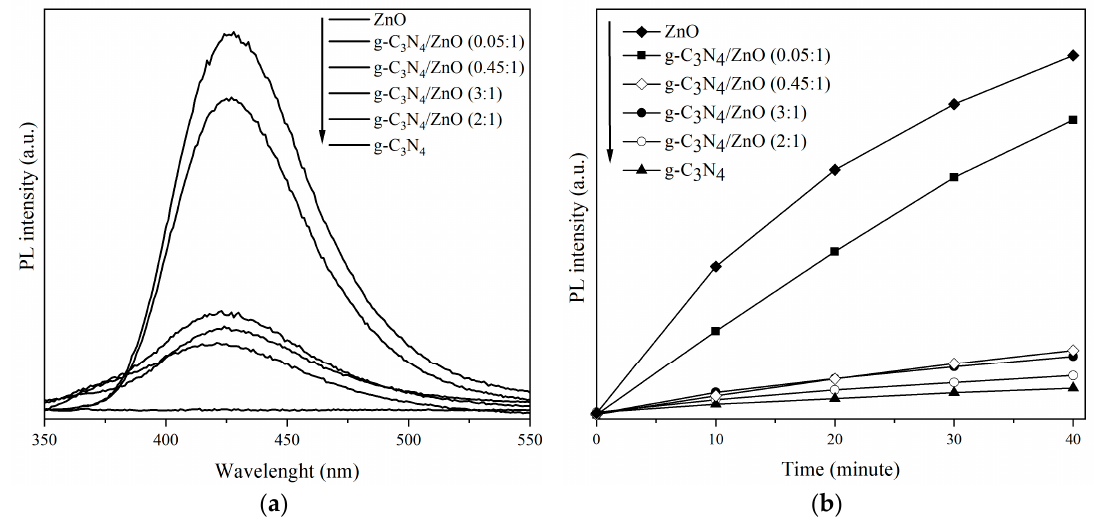
Figure 9. PL spectra in presence of TA in NaOH solution (excitation wave: 365 nm), irradiated for 40 min in the presence of ZnO, g-C 3 N 4 , and g-C 3 N 4 /ZnO ( a ) and a comparison of the PL intensity against irradiation time for of g-C 3 N 4 /ZnO nanocomposites ( b ).